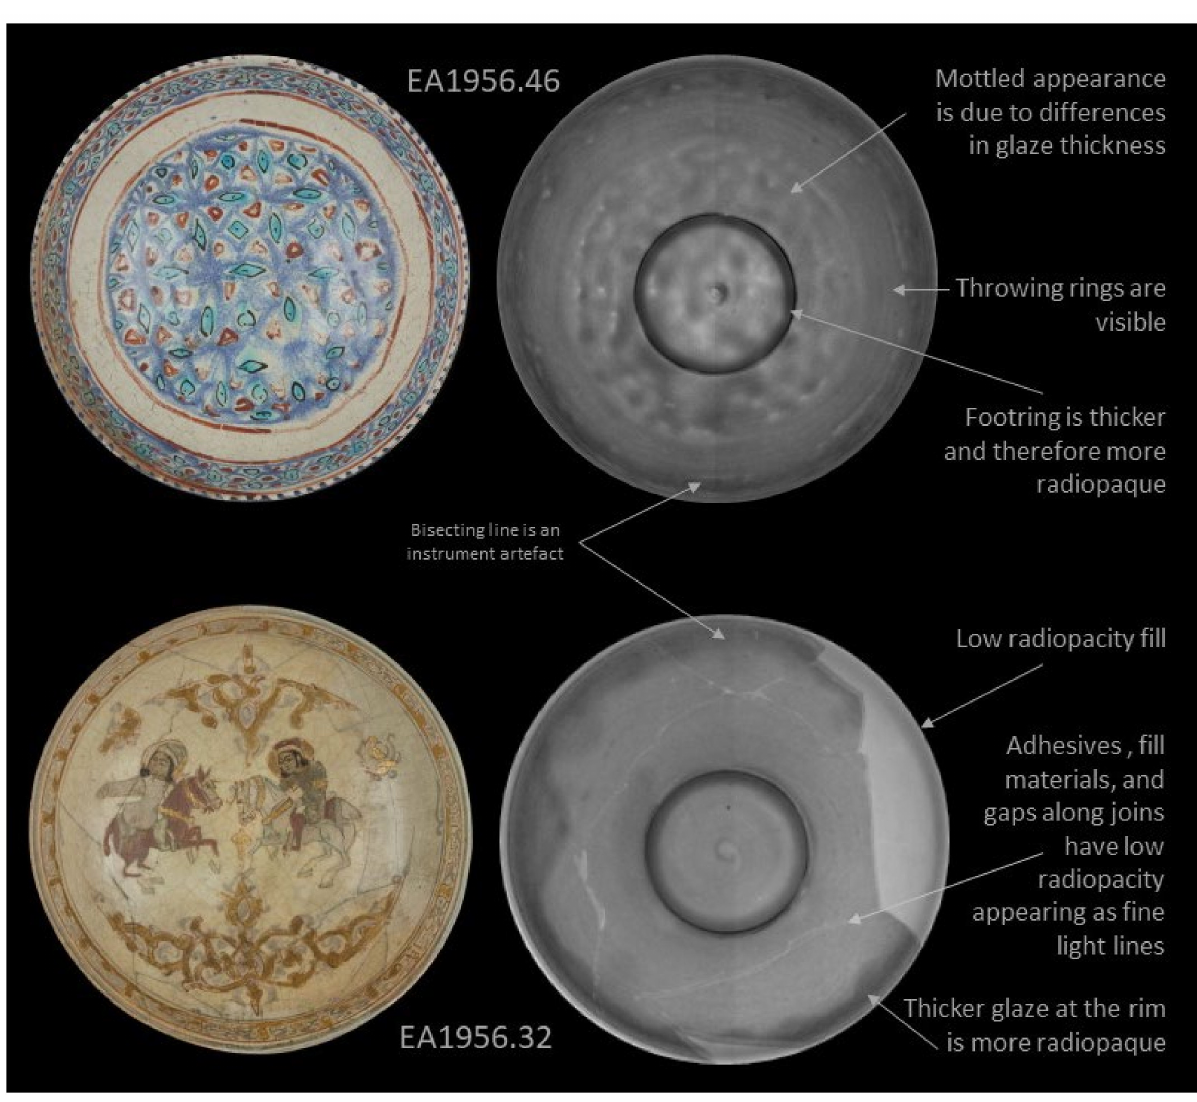
Figure 4. Results of digital photography on the left compared to digital radiographs on the right for EA1956.46 and